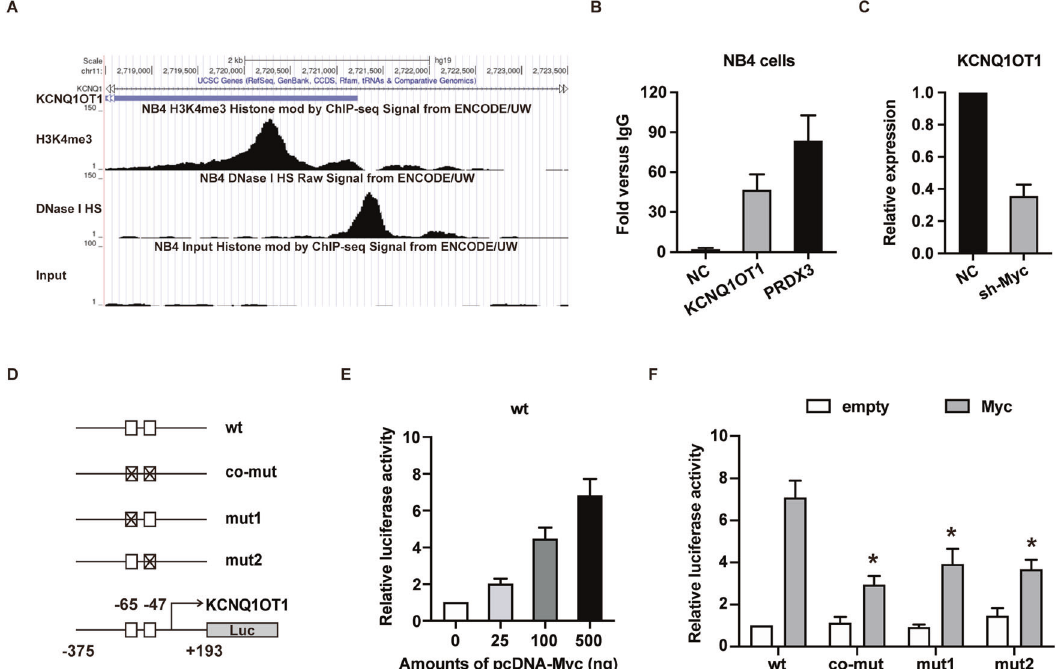
Fig. 6 c-Myc transactivates KCNQ1OT1 expression in APL cells. A Genome browser screenshot of the KCNQ1OT1 locus. H3K4Me3 (GSM945275), DNase I HS signal (GSM736604), and Input (GSM945252) ChIP-seq signals of NB4 cells were displayed in the UCSC genome browser. B ChIP assay was performed to investigate the interaction between c-Myc and KCNQ1OT1 promoter. PRDX3 was used as the positive control. C The expression level of KCNQ1OT1 was determined in NB4 cells infected with shRNA speci fi cally targeting c-Myc (shMyc). D Schema of the KCNQ1OT1 promoter region shows the different mutation constructs used in this study. □ represents the wild-type c-Myc binding site and ⊠ represents the mutated site. E The 568bp KCNQ1OT1 promoter reporter construct was transfected into 293T cells along with increasing amounts of the pcDNA- Myc expression plasmid. Luciferase activity was measured 24h after transfection. F The luciferase promoter constructs with mutated − 65 and/or − 47 sites were co-transfected with 500 ng of the pcDNA3.1 (empty) or pcDNA-Myc (Myc) plasmid into 293T cells. Luciferase activities were measured 24 h after transfection. The result is presented with the means ±SEM of at least three independent experiments. * p